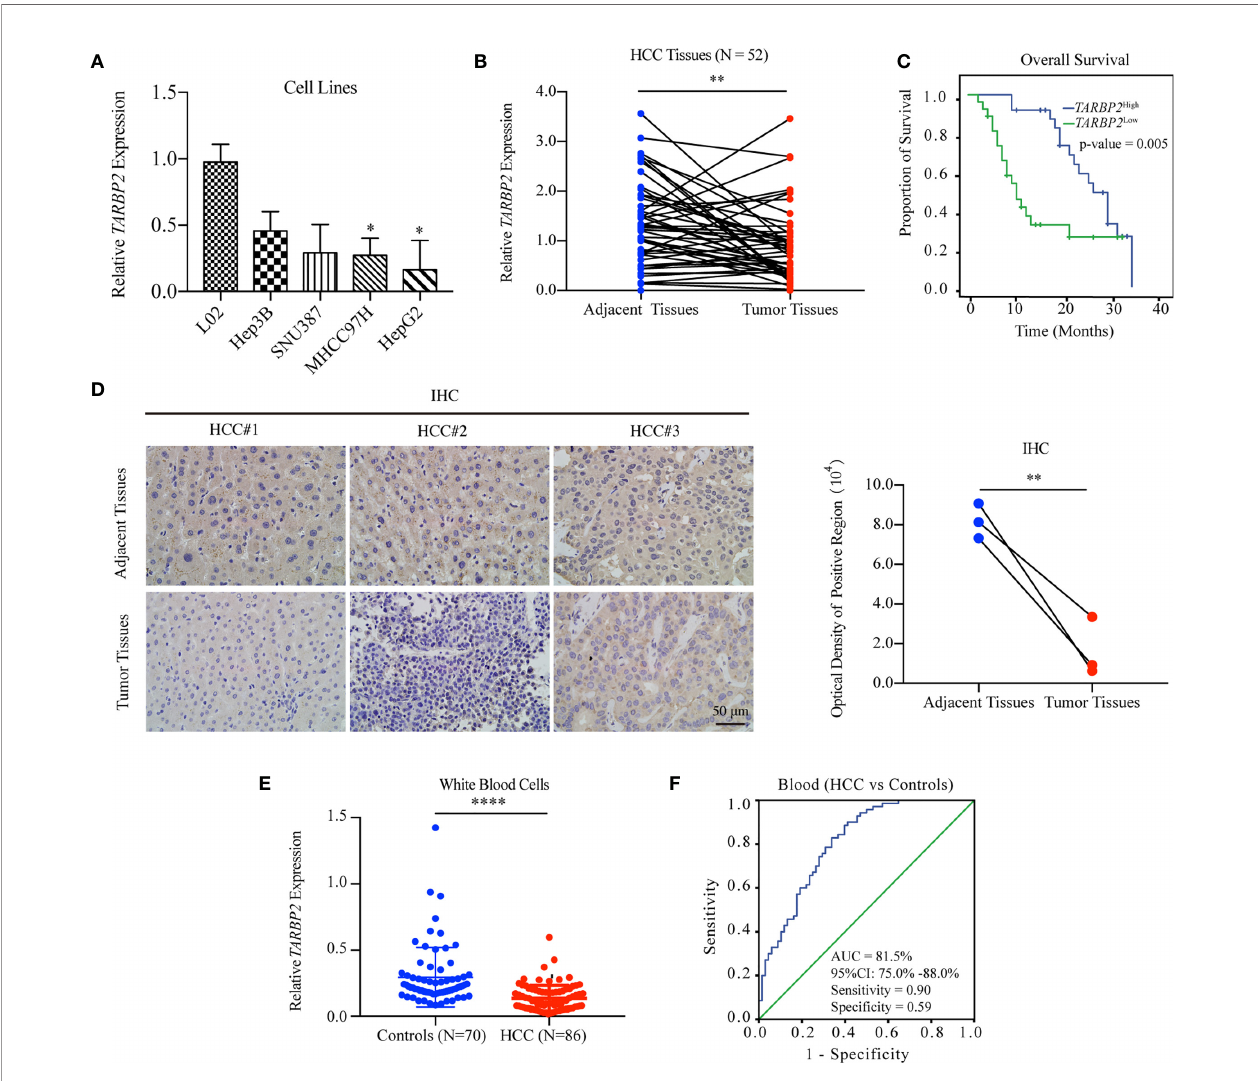
FIGURE 1 | Downregulation of TARBP2 in HCC is associated with poor prognosis. (A) The mRNA expression of TARBP2 was consistently downregulated across HCC cell lines compared with the normal liver L02 cells. (B) Downregulation of TARBP2 mRNA was con fi rmed in 52 pairs of patient-derived HCC tumors and adjacent tissues. (C) HCC patients with a relatively lower mRNA expression of TARBP2 had a worse three-year OS. (D) The protein expression of TARBP2 was higher in adjacent tissues relative to tumors. (E) The mRNA expression of TARBP2 in patient-derived blood samples was lower relative to healthy controls. (F) TARBP2 mRNA expression in the blood distinguished HCC patients from healthy controls. OS, overall survival; IHC, immunohistochemistry; AUC, area under curve; CI, con fi dence interval; *p-value < 0.05; **p-value < 0.01; ****p-value <